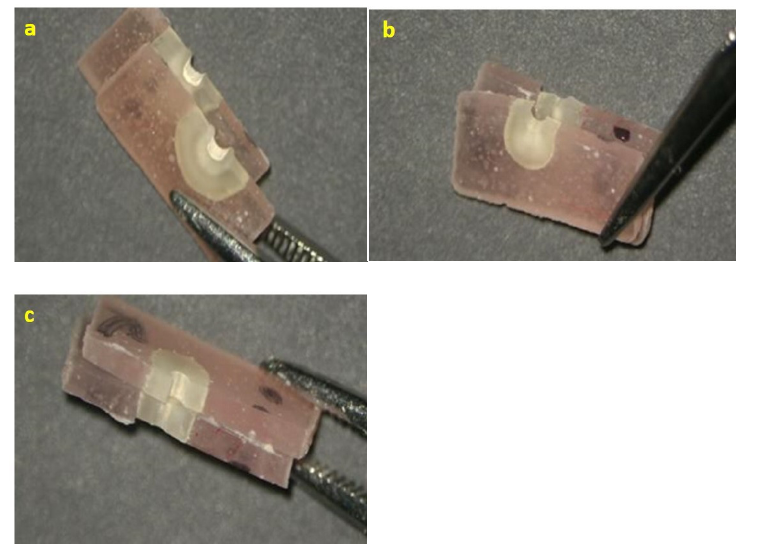
Figure 4. Representative failure modes for tested endodontic sealers: ( a ) cohesive EBCS; ( b ) adhesive RSSE; ( c ) mixed BRS.